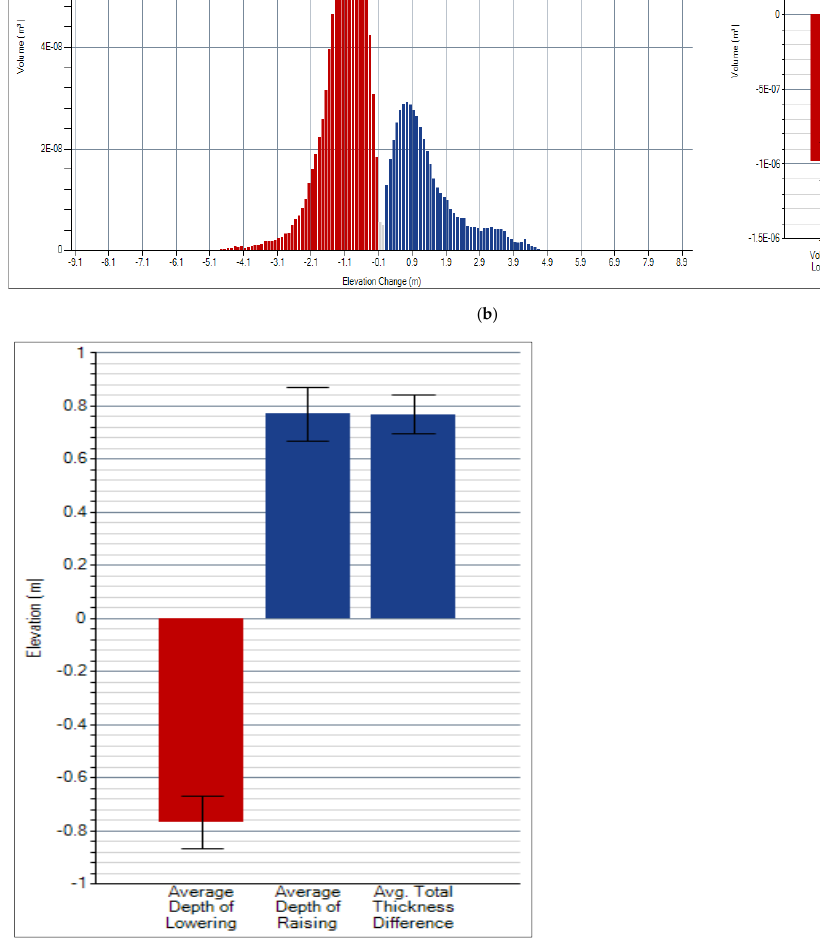
Figure A6. GCD result for ROI7.